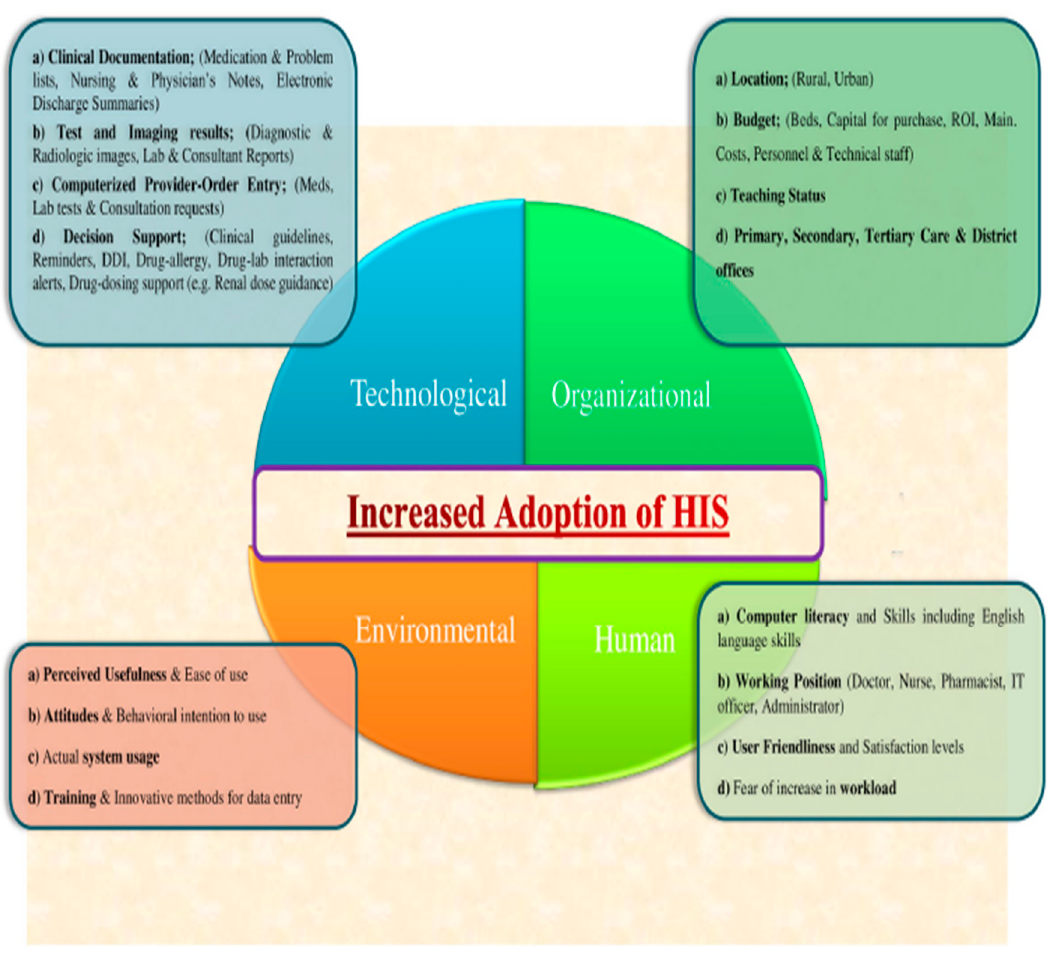
Figure 2. Effective health information system associations with the driving adoption determinants. Source: [27].